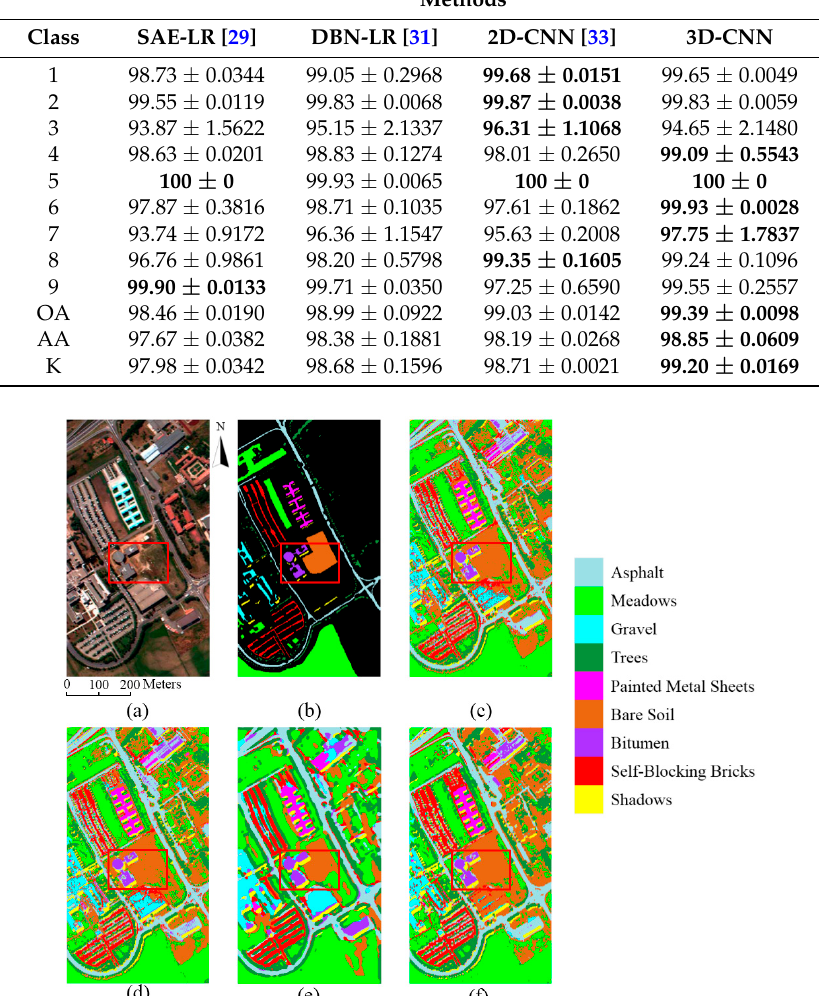
Figure 7. Classification results of Pavia University scene. ( a ) False-color composite; ( b ) Ground truth; ( c ) SAE-LR, OA = 98.46%; ( d ) DBN-LR, OA = 98.99%; ( e ) 2D-CNN, OA = 99.03%; ( f ) 3D-CNN, OA =